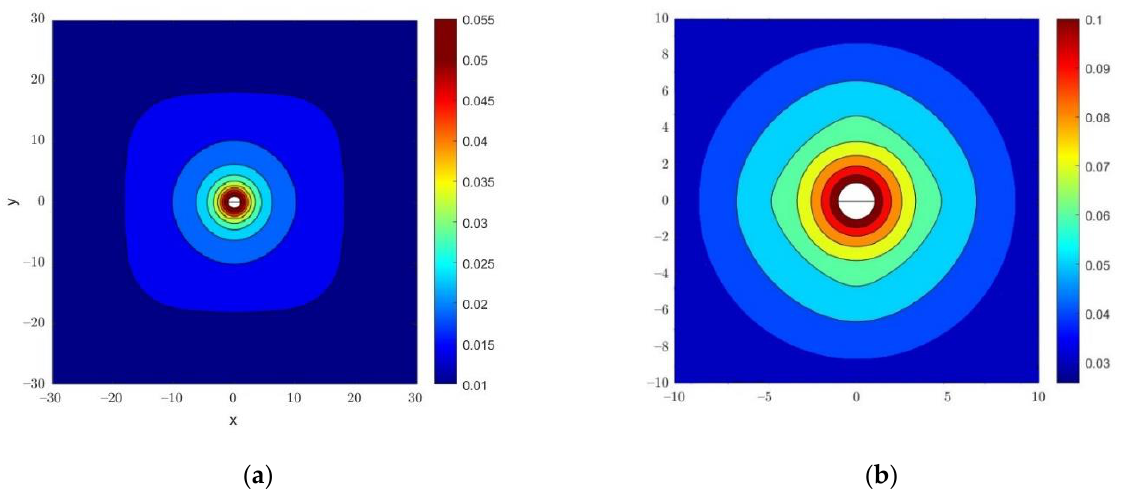
Figure 10. Radiated wave amplitude distribution on the free surface using ADZ: ( a ) low wave frequency ( ω = 1.5 rad/s); ( b ) high wave frequency ( ω = 3.0 rad/s).